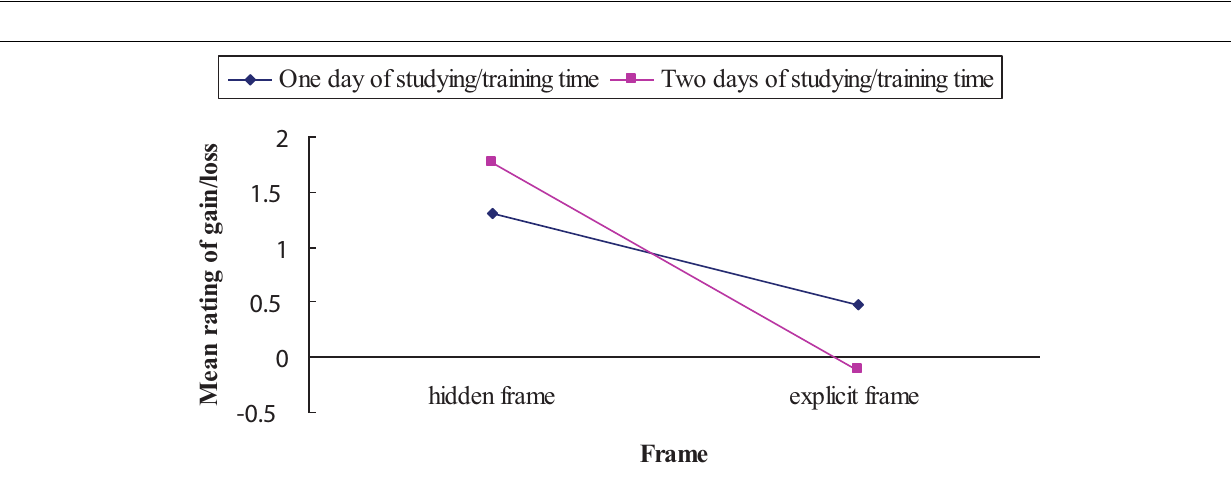
FIGURE 2 | Mean rating of gain/loss as a function of frame (explicit frame vs. hidden frame) and studying/training time (1 day vs. 2 days). Negative scores indicate that “studying/training time” was seen as loss ; positive scores indicate that “studying/training time” was seen as gain